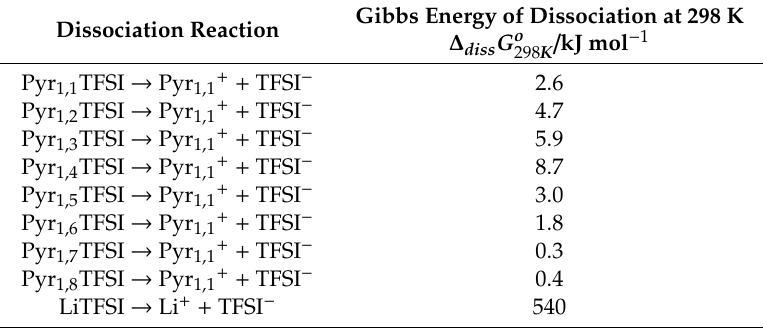
Table 1. Summary of the Gibbs energy of dissociation of the various ionic liquids.